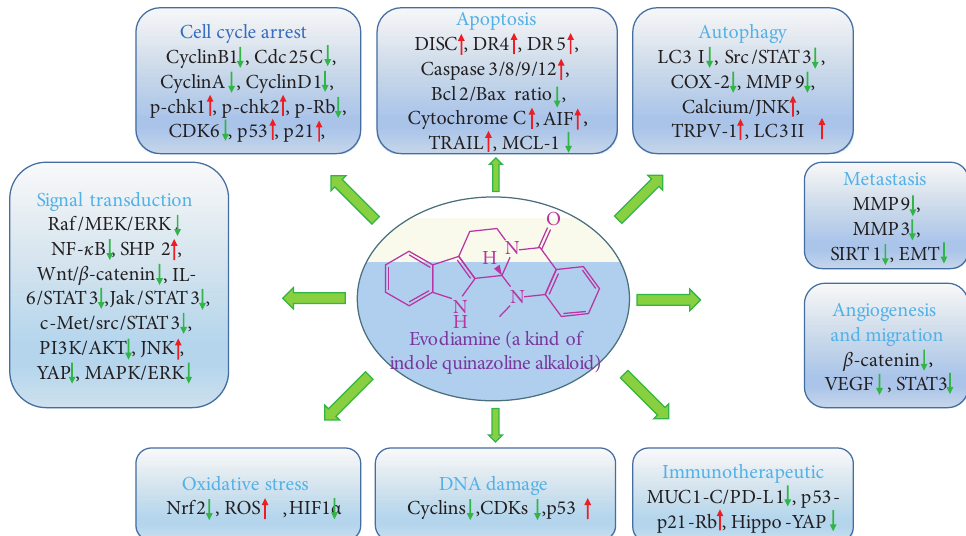
Figure 1: Synopsis of the multifactorial mode of action of evodiamine-type